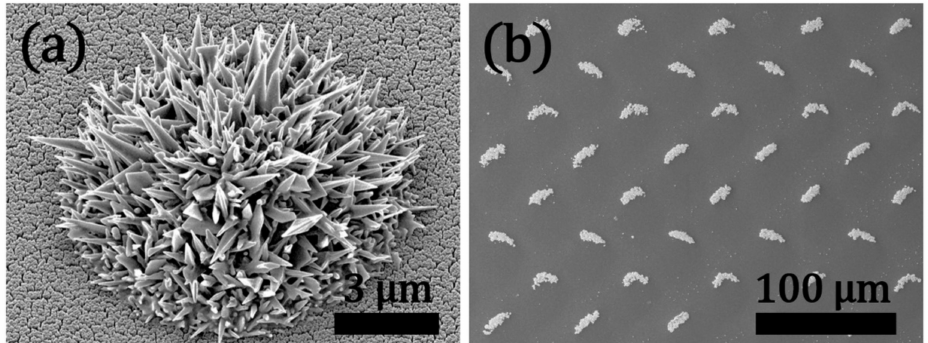
Figure 12. ( a ) Helium ion microscopy (HIM) image of hierarchical Au needle clusters (HAuNC) deposited on a highly activated TiO 2 thin film and ( b ) SEM image of TiO 2 thin film patterned with HAuNCs using a simple non-contact polymer mask. Adapted with permission from [53]. Copyright (2018)